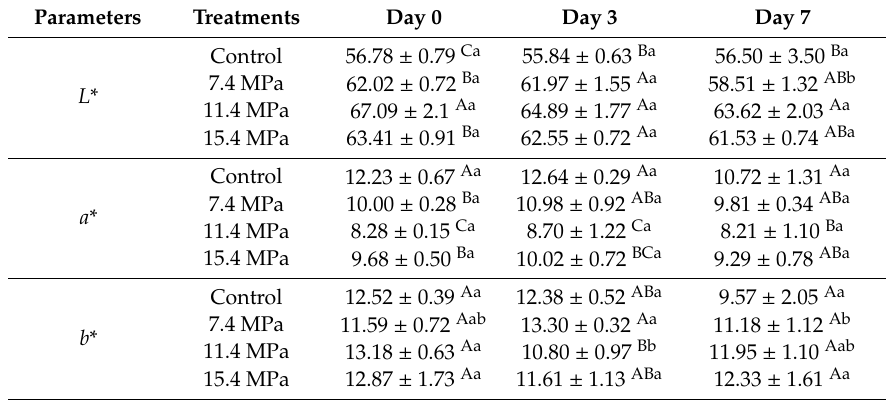
Table 2. E ff ects of three levels (7.4, 11.4 and 15.4 MPa) of SC-CO 2 at 31 ◦ C for 10 min on L *, a * and b * values of raw chicken meat stored at 4 ± 1 ◦ C for seven